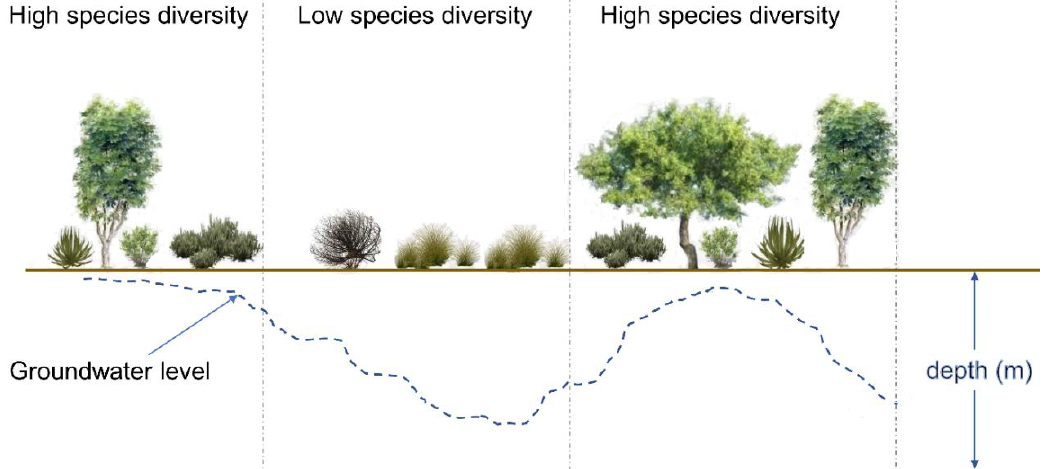
Figure 2. The conceptual interaction of groundwater and vegetation diversity in arid